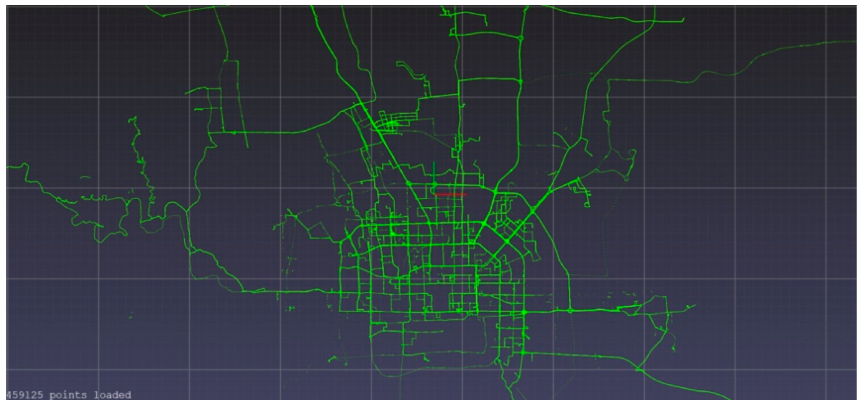
Figure 1. Car trajectories around the capitol of China, Beijing.